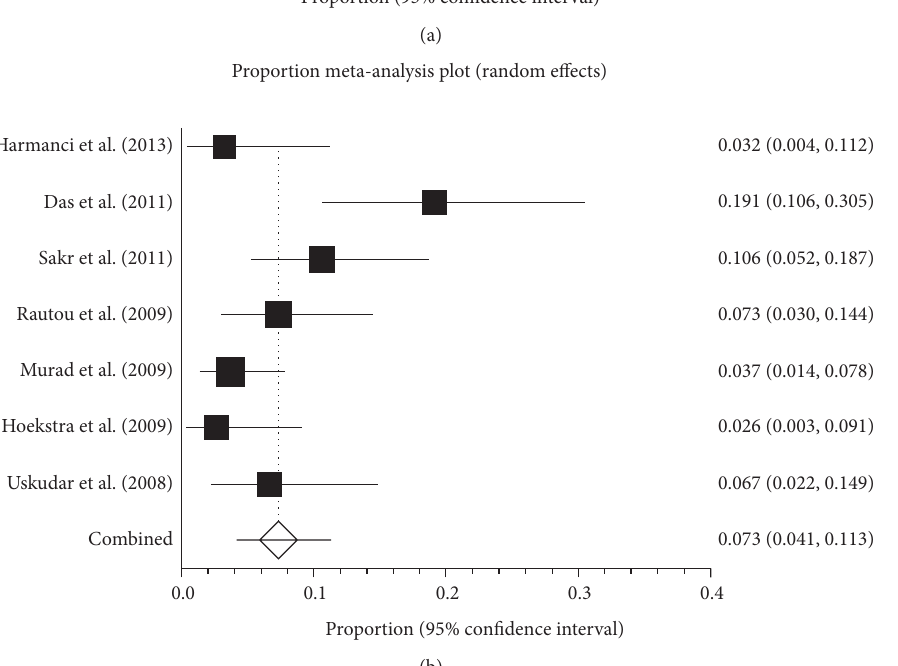
Figure 6: Forest plots of prevalence of pregnancy-related BCS according to the publication year ((a): before 2005, (b): after 2005).